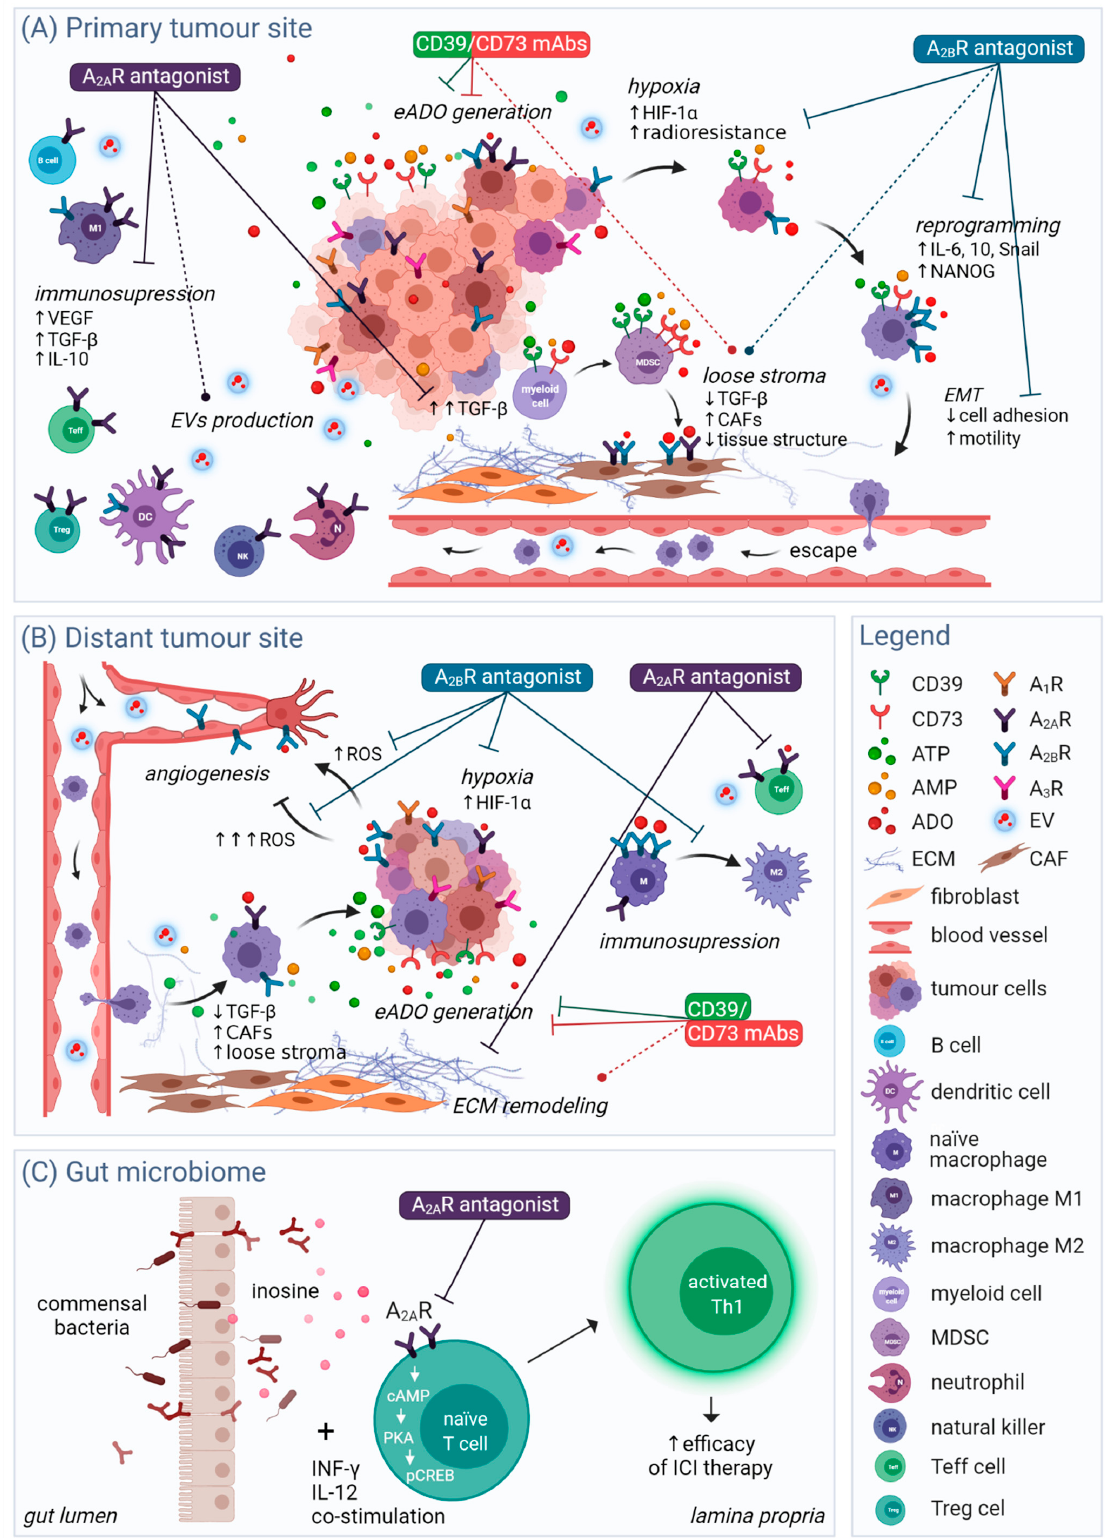
Figure 2. Selected aspects of the multilevel impact of novel adenosinergic therapies. ( A ) At the primary tumour site and ( B ) distant tumour site, the blockage of CD39/73 by mAbs attenuates the generation of eADO from its precursor